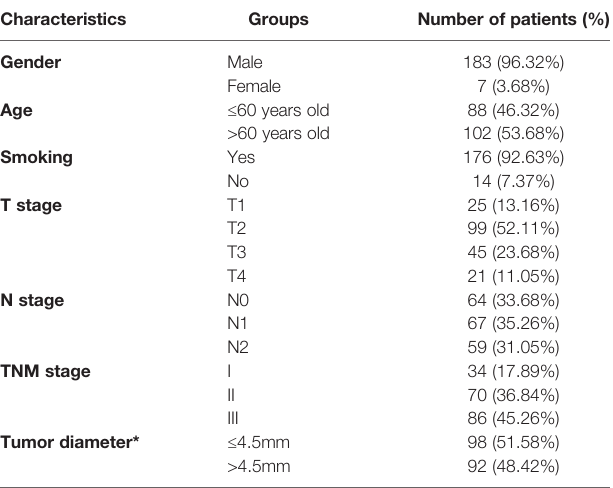
TABLE 1 | Clinicopathological characteristics of SqCLC patients in tissue